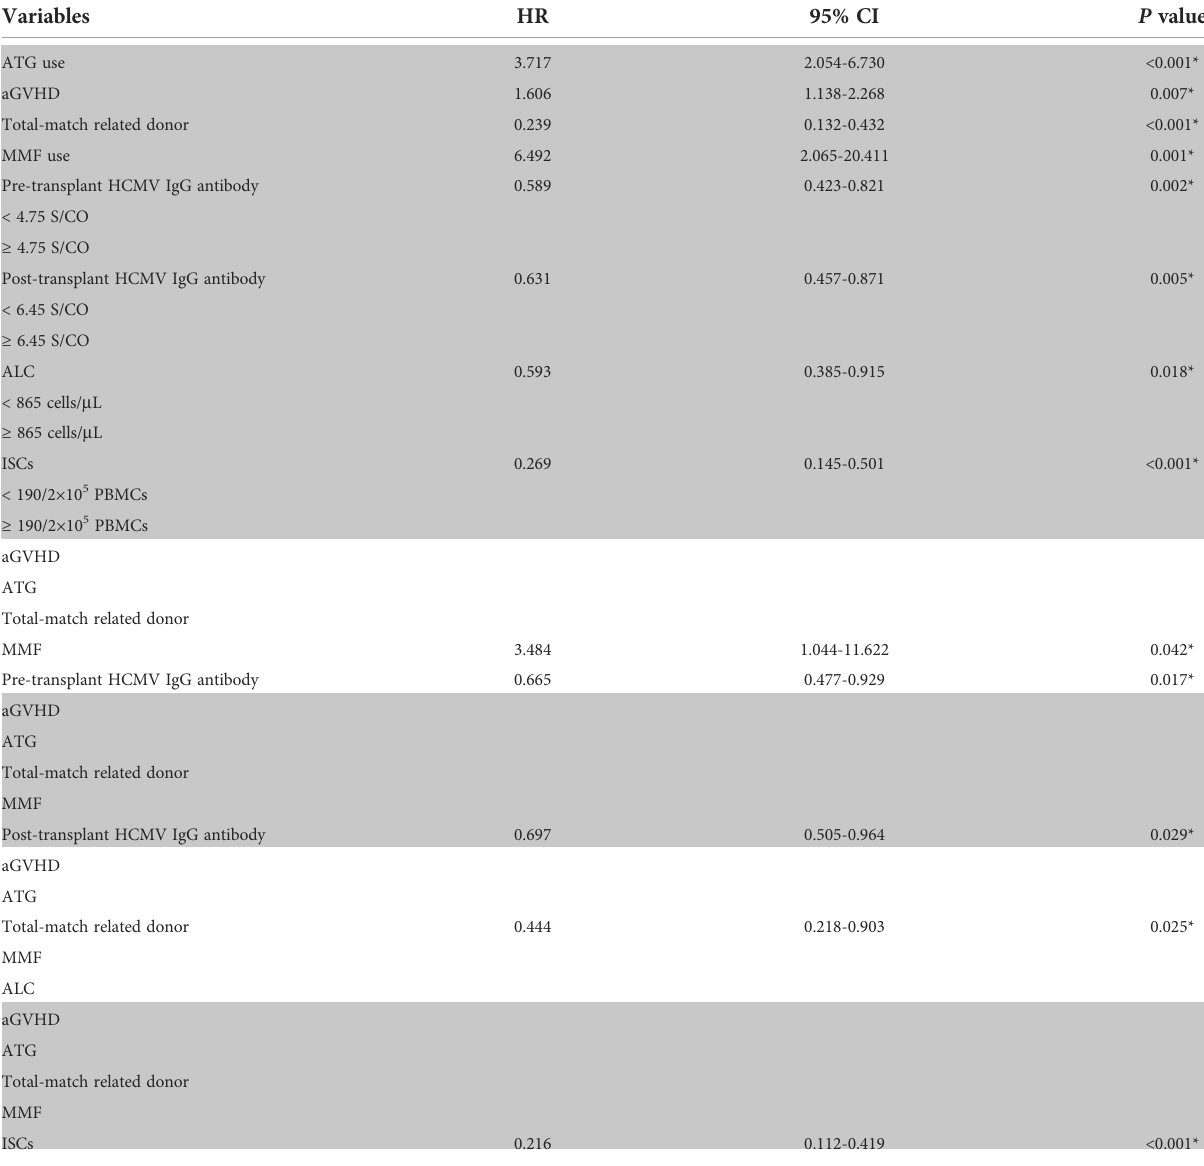
TABLE 2 Univariable and multivariate analysis of factors affecting HCMV